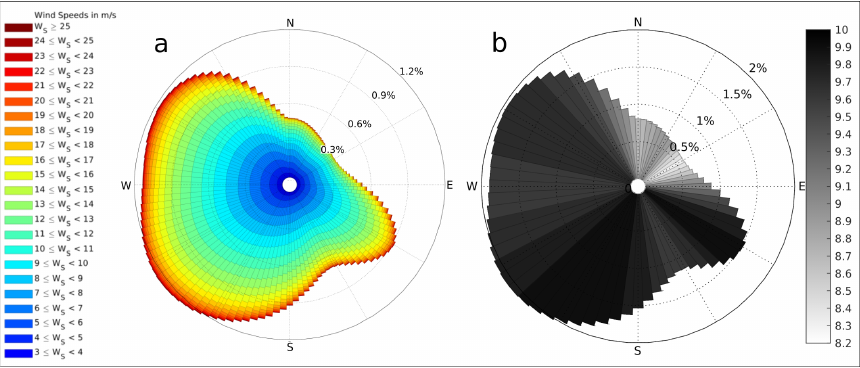
Figure 4. Wind roses from Horns Rev used respectively for evaluation ( a ) and evolution ( b